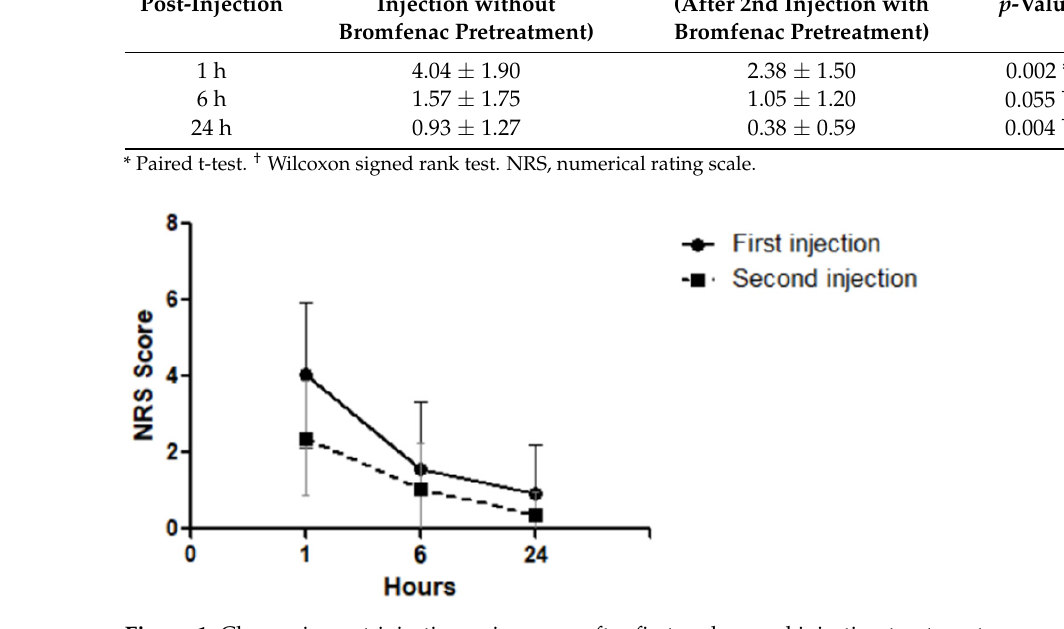
Table 2. Change in post-injection pain scores after first and second injection treatments. Post-Injection